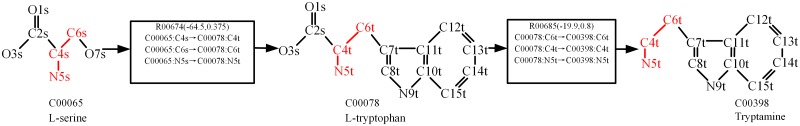
Illustration of an atomic group transfer graph.The atomic group transfer graph contains three compounds and two reactions, where reaction R00674 links input compound C00065 and output compound C00078, reaction R00685 links input compound C00078 and output compound C00398, the data in parentheses denote the Gibbs free energy and compound similarity respectively, hydrogens and their associated bonds are not shown.